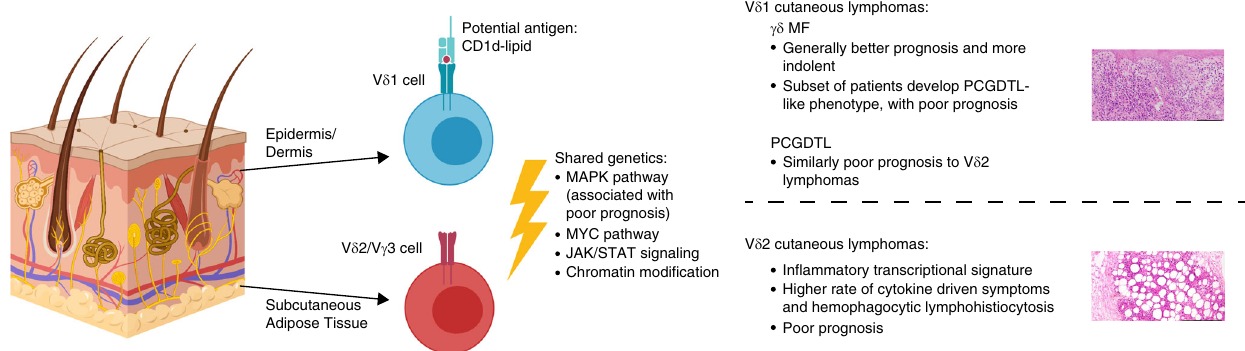
Fig. 6 Proposed model of CGDTL cell of origin and disease pathogenesis. Epidermal/dermal disease arises from the V δ 1 cell and can potentially bind to lipid antigens presented by CD1d. Panniculitic disease arises from the V δ 2/V γ 3 cell in the subcutaneous tissue. Both cells acquire similar genetic alterations. V δ 1 γδ MFs clinically can have either a non-cytotoxic, indolent course or can switch after prolonged indolence to a cytotoxic phenotype that is more aggressive. V δ 2 lymphomas are more aggressive, associated with in fl ammatory gene signatures and the development of cytokine-driven paraneoplastic syndromes including hemophagocytic lymphohistiocytosis. Scale bar represents 100 μ m (top) and 200 μ m (bottom). Created with BioRender. Table 1 Putative clinically actionable mutations detected in CGDTL.